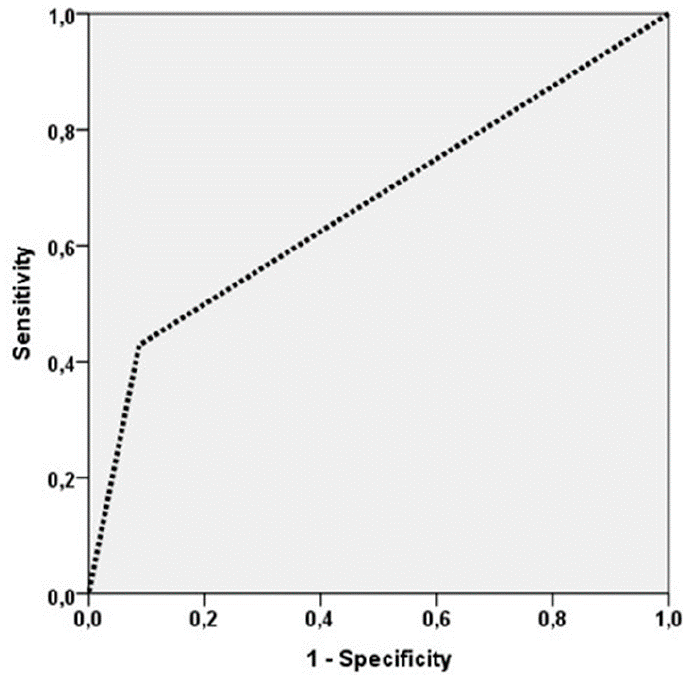
Figure 2. ROC curve for the sentinel lymph node biopsy (SLNB) technique, representing the sensitivity and 1-Specificity.